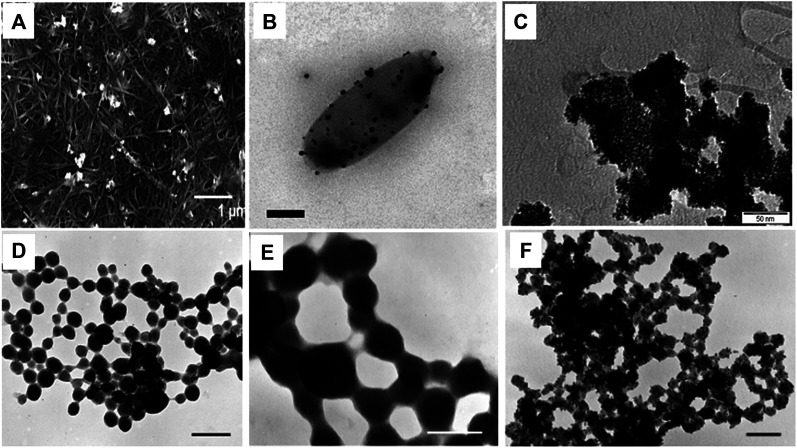
Morphologies of bacteriogenic PtNPs. (A) SEM images of Pt-BCcm membrane obtained from K2PtCl4 solution at 10mM where inset scale bar represents 1 µm (Aritonang et al., 2014); (B) Representative electron micrographs of PtNPs produced by D
.
alaskensis G20 which are exported and found on the surface of the cell where inset scale bar represents 200 nm (Capeness et al., 2015); (C) TEM image of recovered bioPt NPs from 1% Pt EcMC4100 after NaOH, washing, and centrifugation treatment where inset scale bar represents 50 nm (Attard et al., 2012); TEM micrographs of whole mounts of partially recrystallized spherical PtNPs in cyanobacteria-PtCl4° systems at (D) at 60°C and 14 days where inset scale bar represents 0.25 µm; (E) at 80°C and 21 days where inset scale bar represents 0.1 µm; (F) 100°C days and 28 days where inset scale bar represents 0.1 µm (Lengke et al., 2006).